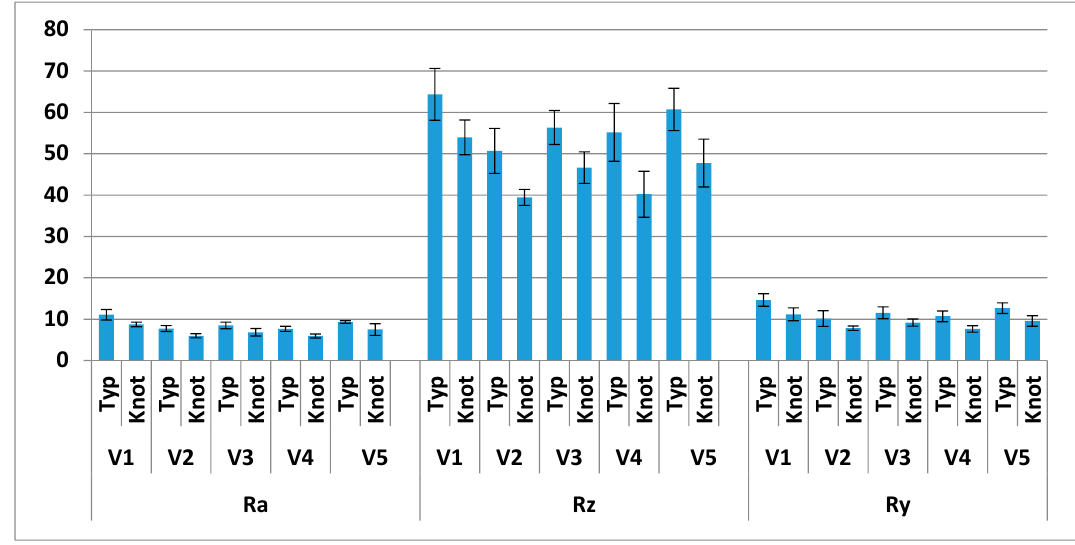
Figure 11. Surface roughness parameters Ra, Rz and Ry (µm) of poplar wood veneers (V1–V5) on typical wood structure areas and areas around live knots. Table 6. Descriptive statistics of dependent variable Ra measured on poplar veneers of typical wood structure areas and areas around a live knot.